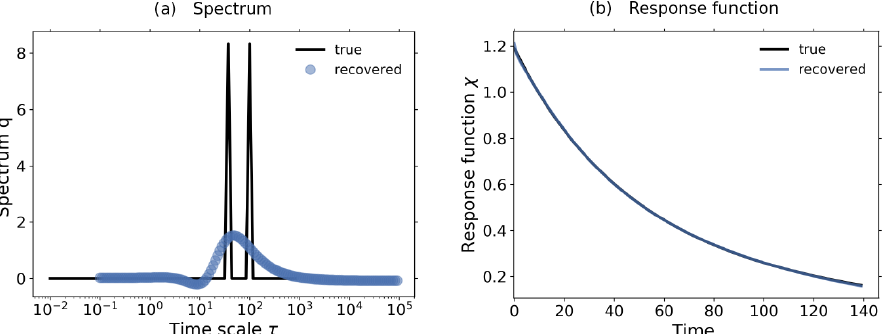
Figure E4. Spectrum q λ and response function χ(t) recovered from a 1% experiment performed with the toy model described in Part 1 taking an underlying discrete spectrum with two timescales τ = 37 and τ = 100. The data were taken with SNR ∼ O ( 10 4 ) − O ( 10 5 ) .